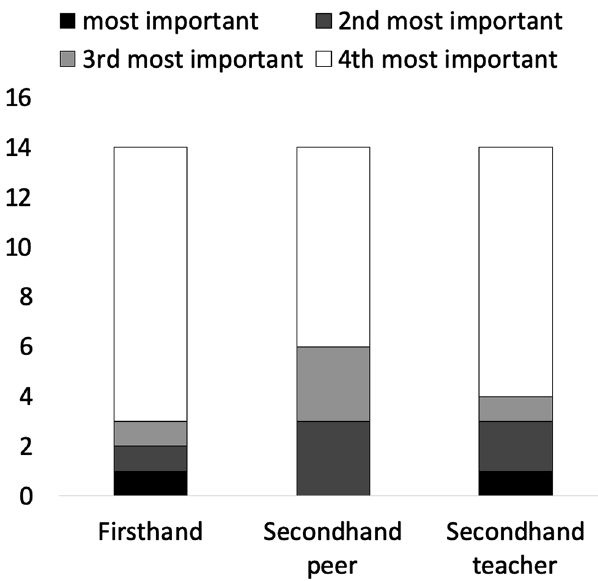
FIG. 3. Students ’ ratings of how important the author who generated the data is (full sample N ¼ 42